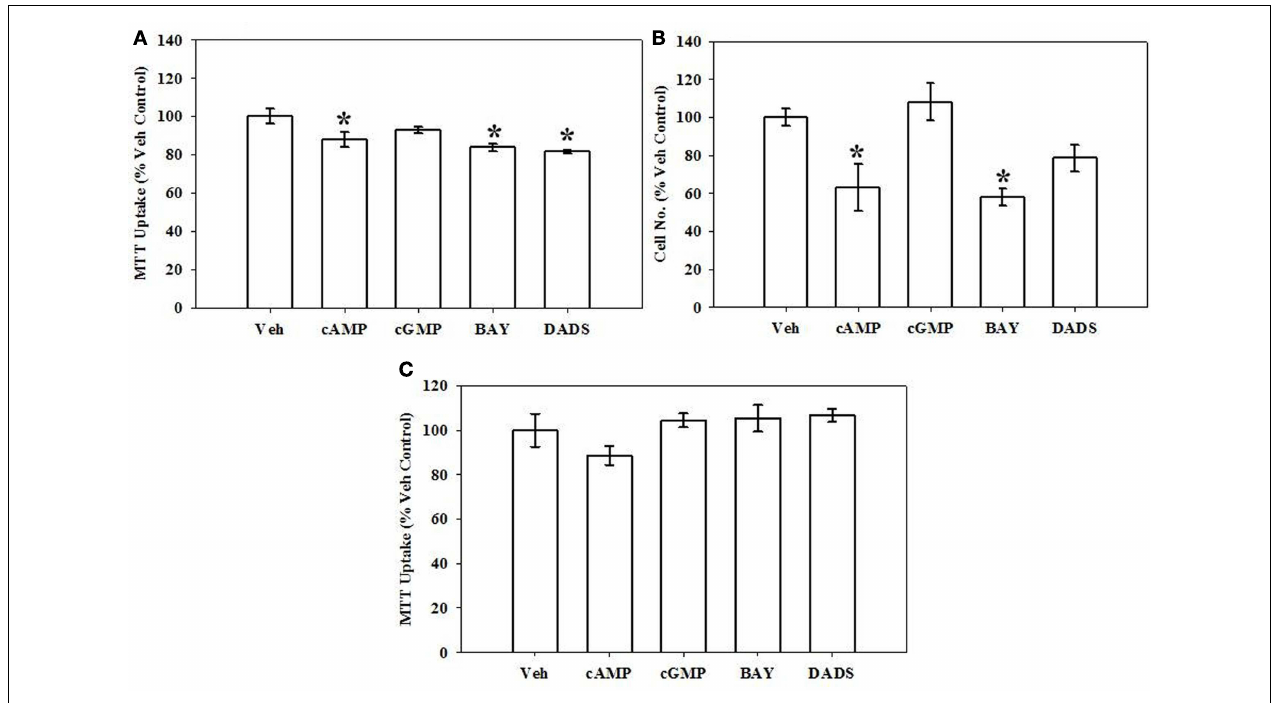
reduced cell numbers by ∼ 40%, and the presence of DADS reduced cell numbers by ∼ 20% ( p = 0.06). Data are mean ± SEM of two independent experiments each with n = 3–4. (C) MTT assay performed onVSMCs after 12h shows no observable changes in any treatment group. Student–Newman–Keuls method for multiple comparisons following one-way ANOVA was used. * p < 0.05 compared with normalized vehicle controls.